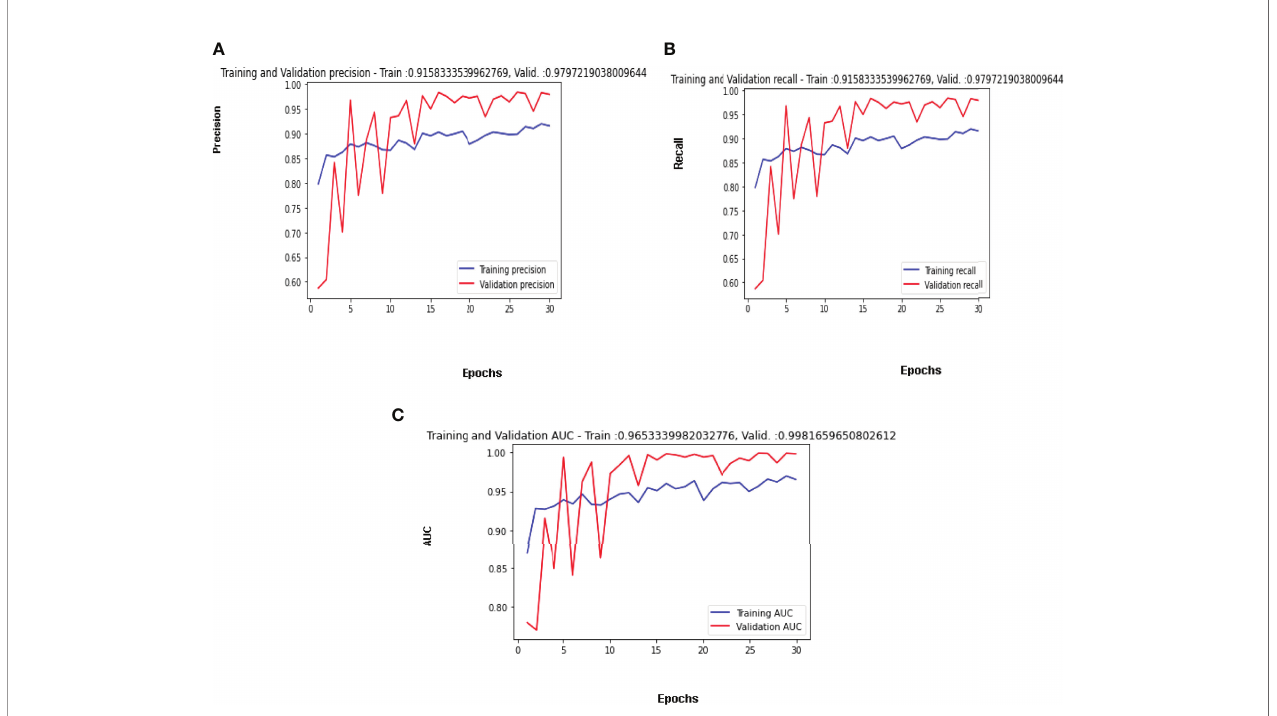
FIGURE 10 | Confusion Matrix Parameter Curves Using Adam Optimizer: (A) Precision, (B) Recall, and (C)